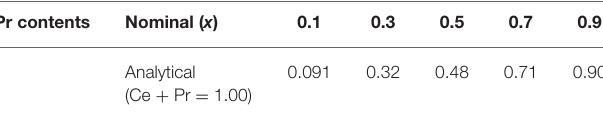
Frontiers in Chemistry |